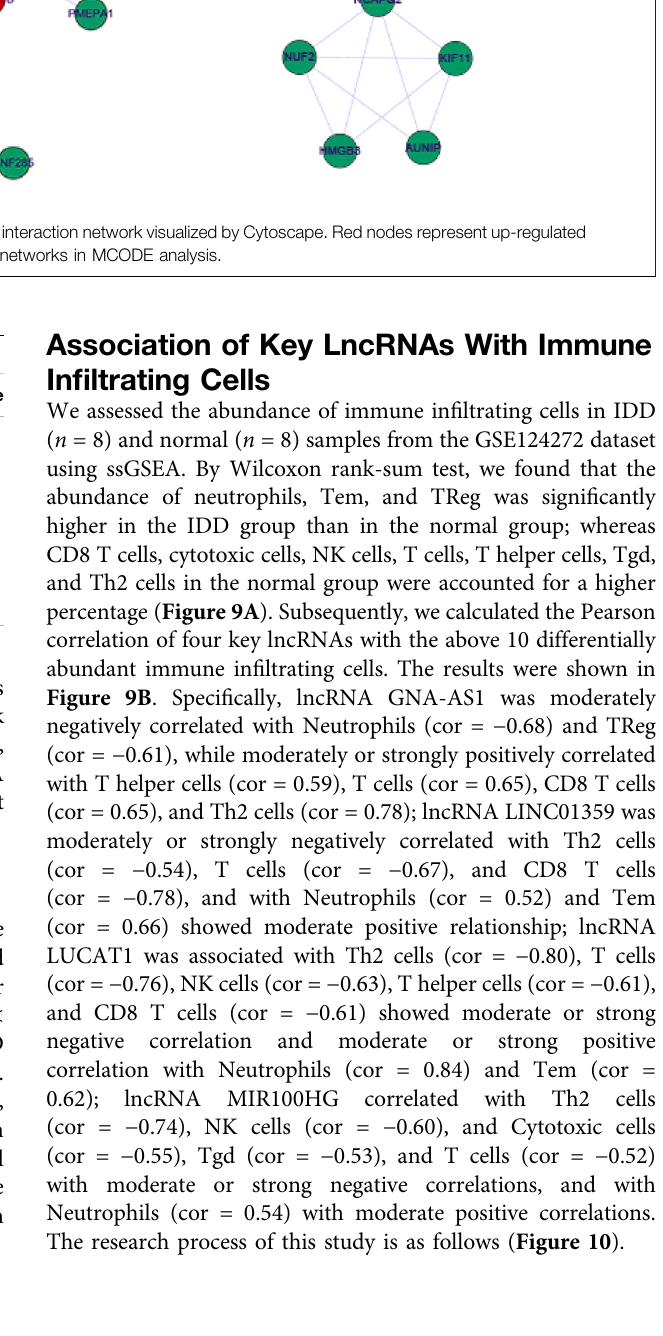
TABLE 4 | The degree values of each lncRNAs in the ceRNA